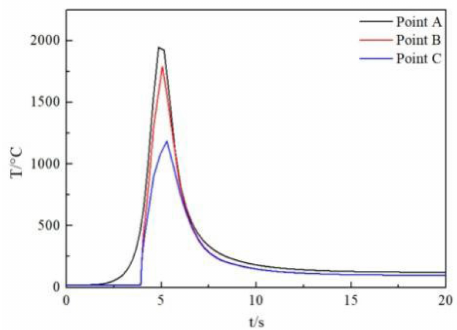
Figure 14. Temperature curve of three points: A, B, and C in the cladding layer.